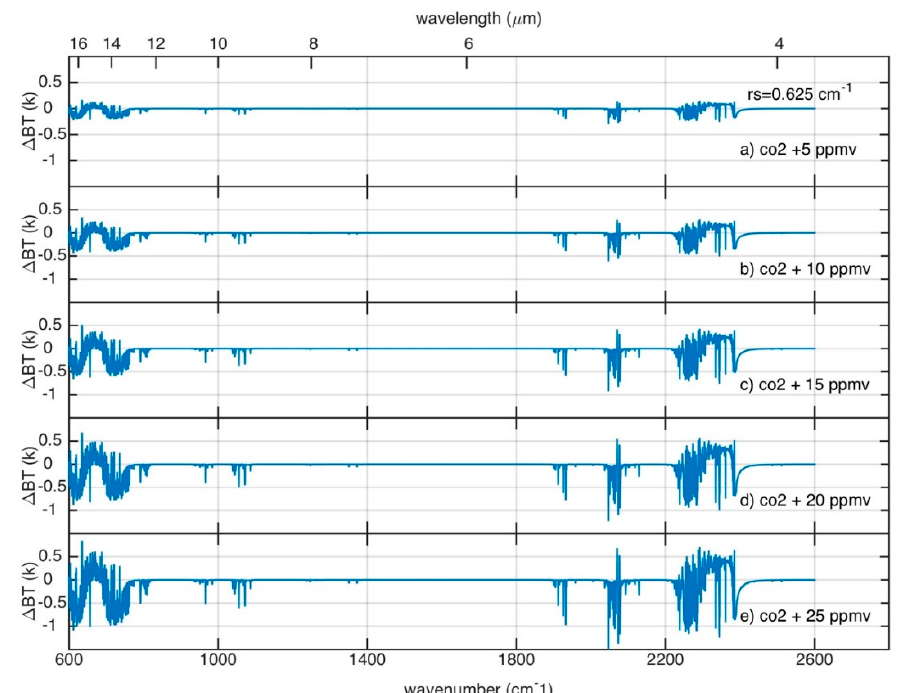
Figure 3. Brightness temperature difference (BTD) when CO 2 concentration profile has an increment of ( a ) 5, ( b ) 10, ( c ) 15, ( d ) 20, and ( e ) 25 ppmv, respectively, at a spectral resolution of 0.625 cm − 1 . The base CO 2 profile is the one fixed in the RTTOV and is around 380 ppmv.